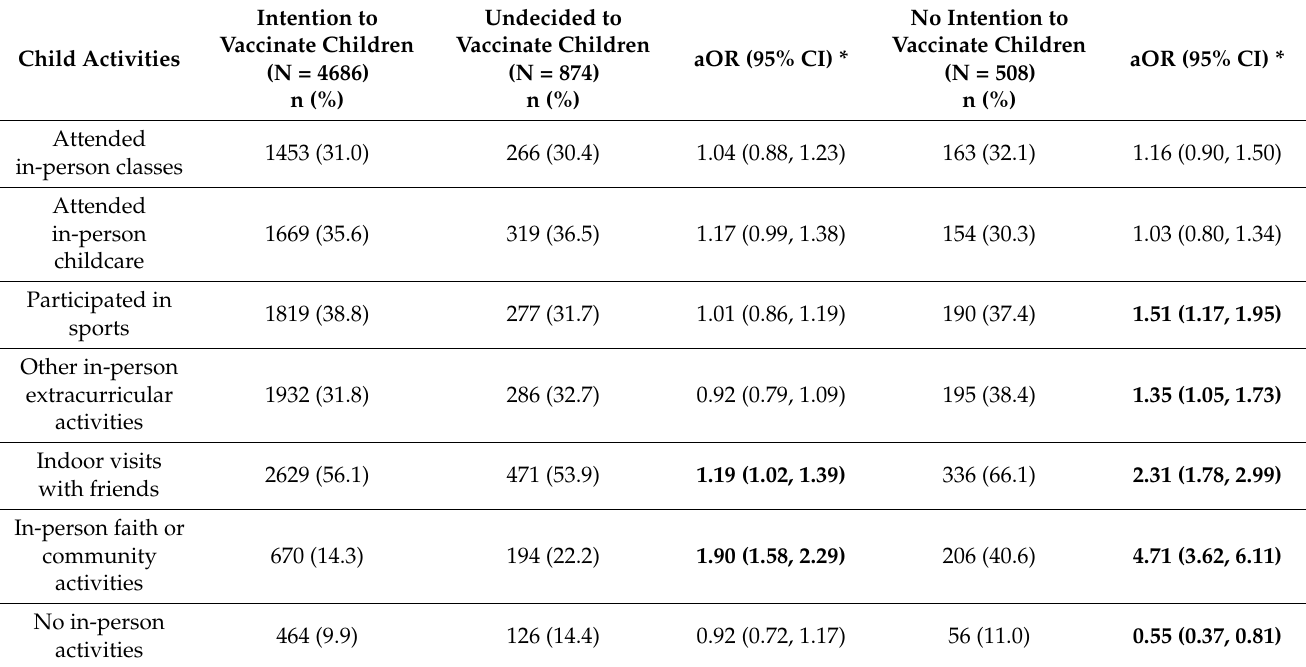
Table 2. Associations between parental intention to vaccinate their children before the 2021–2022 school year and child activities, May–September